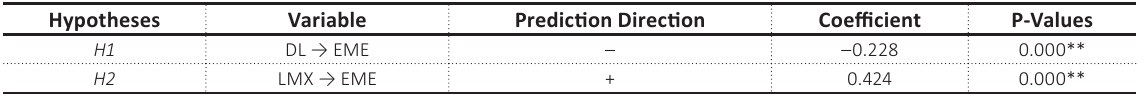
Source: SmartPLS 3 processing results.